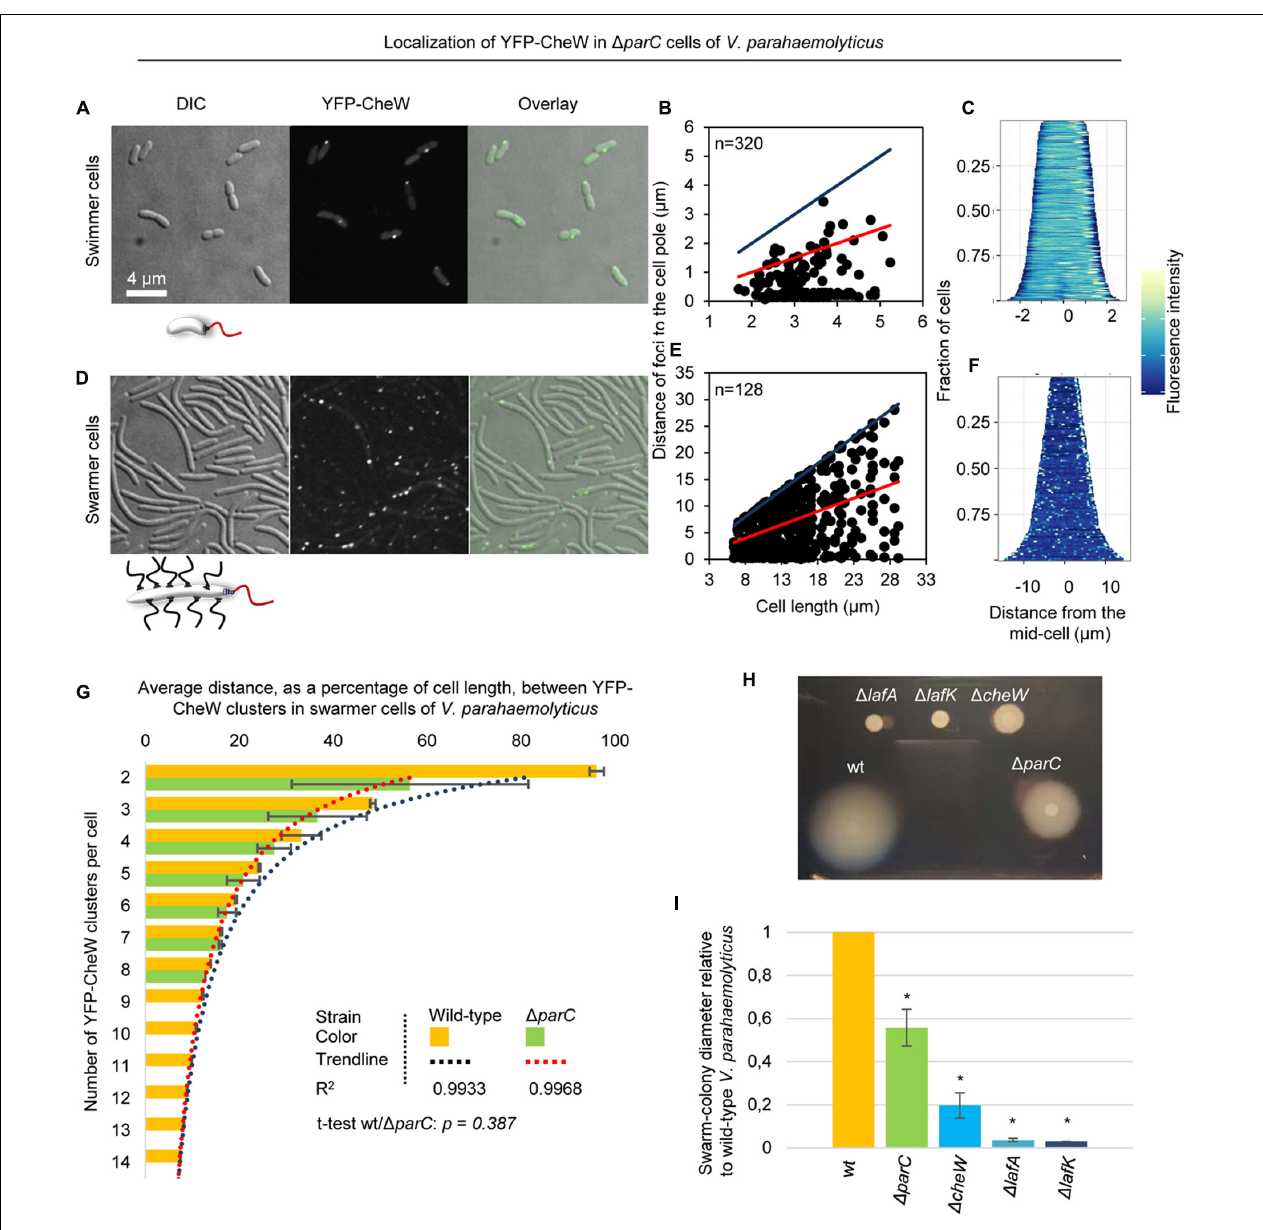
FIGURE 6 | Localization of chemotactic signaling arrays in the absence of ParC. Intracellular localization of YFP-CheW in V. parahaemolyticus (cid:49) parC swimmer (A–C) and swarmer cells (D–F) . (A,D) Microscopy showing the intracellular localization of YFP-CheW in swimmer (A) and swarmer cells (D) deleted for parC . (B,E) Graph depicting the distance of YFP-CheW foci from the cell poles as a function of cell length in swimmer (B) and swarmer cells (E) deleted for parC . (C,F) demographic analysis showing the fluorescence intensity of YFP-CheW along the cell length in a population of V. parahaemolyticus relative to cell length in swimmer (C) and swarmer cells (F) deleted for parC . (G) Bar graph showing the average distance between YFP-CheW clusters relative to cell length as a function of the number of YFP-CheW clusters per cell in wild-type and (cid:49) parC swarmer cells of V. parahaemolyticus . Data for wild-type is shown in orange and (cid:49) parC in green. The R 2 value refer to the significance of the trendline. The t -test refer to the similarity between wild-type and a (cid:49) parC strain. (H) Swarming colony formation of wild-type (wt), (cid:49) lafA , (cid:49) lafK , (cid:49) cheW , and (cid:49) parC strains of V. parahaemolyticus . (I) Diameter of swarm-colonies of wild-type (wt), (cid:49) lafA , (cid:49) lafK , (cid:49) cheW , and (cid:49) parC strains of V. parahaemolyticus relative to wild-type. Asterisk indicates p < 0.005